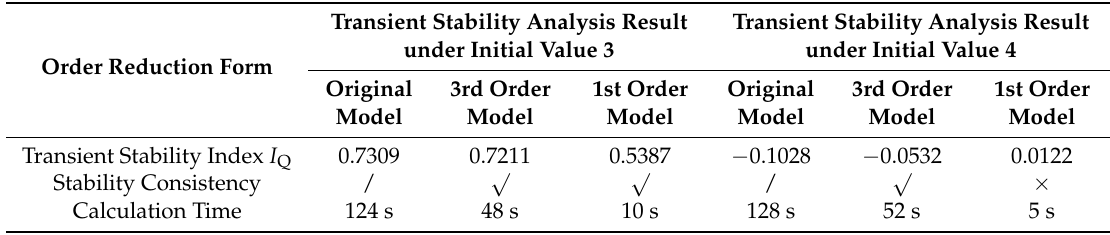
Table 9. Transient stability analysis of test system 2.